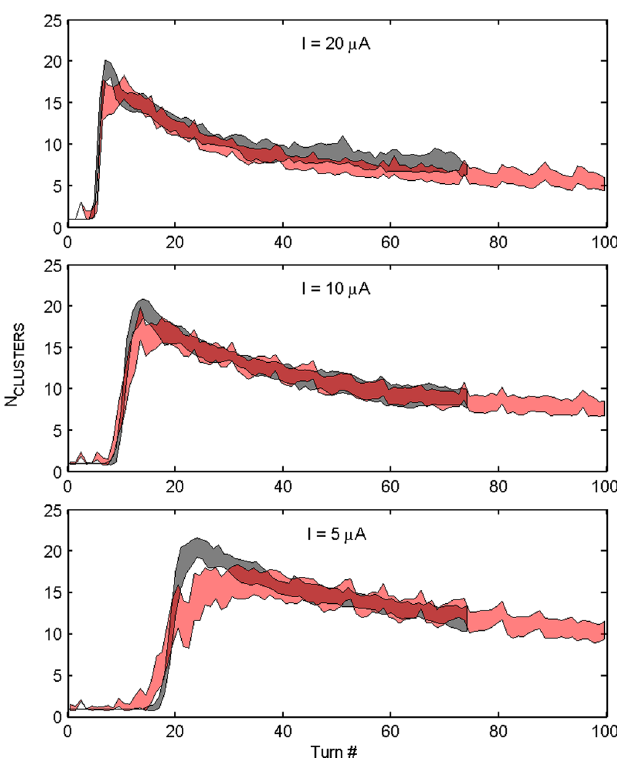
FIG. 13. (Color) Simulated (in grey) and experimentally mea- sured (in red) number of linear charge density peaks vs turn number for three different beam intensities: 5, 10, and 20 (cid:3) A . Experimental and simulated data closely overlap.